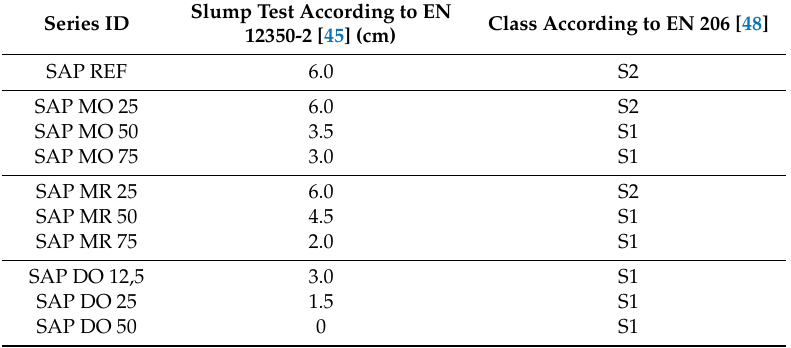
Table 6. The results of a slump test performed on concrete mixes modified with superabsorbent polymers (SAP) and on the reference series.